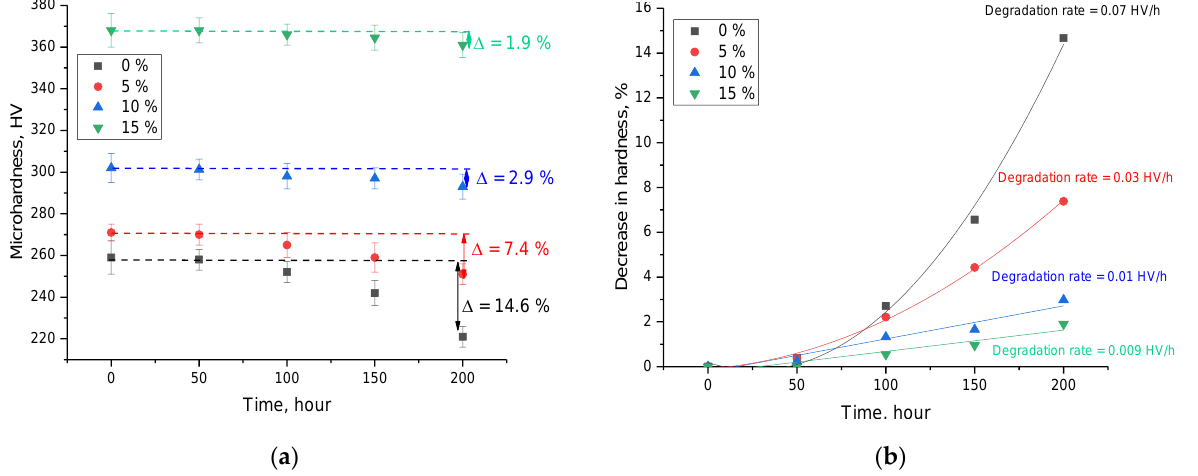
Figure 6. The results of high-temperature tests for resistance to external influences: ( a ) Change in microhardness depending on the test time (the dotted lines indicate the microhardness of ceramics in the initial state, which are given as a comparison to assess the trend of changes); ( b ) Data of change in the degradation and hardness decrease rate.